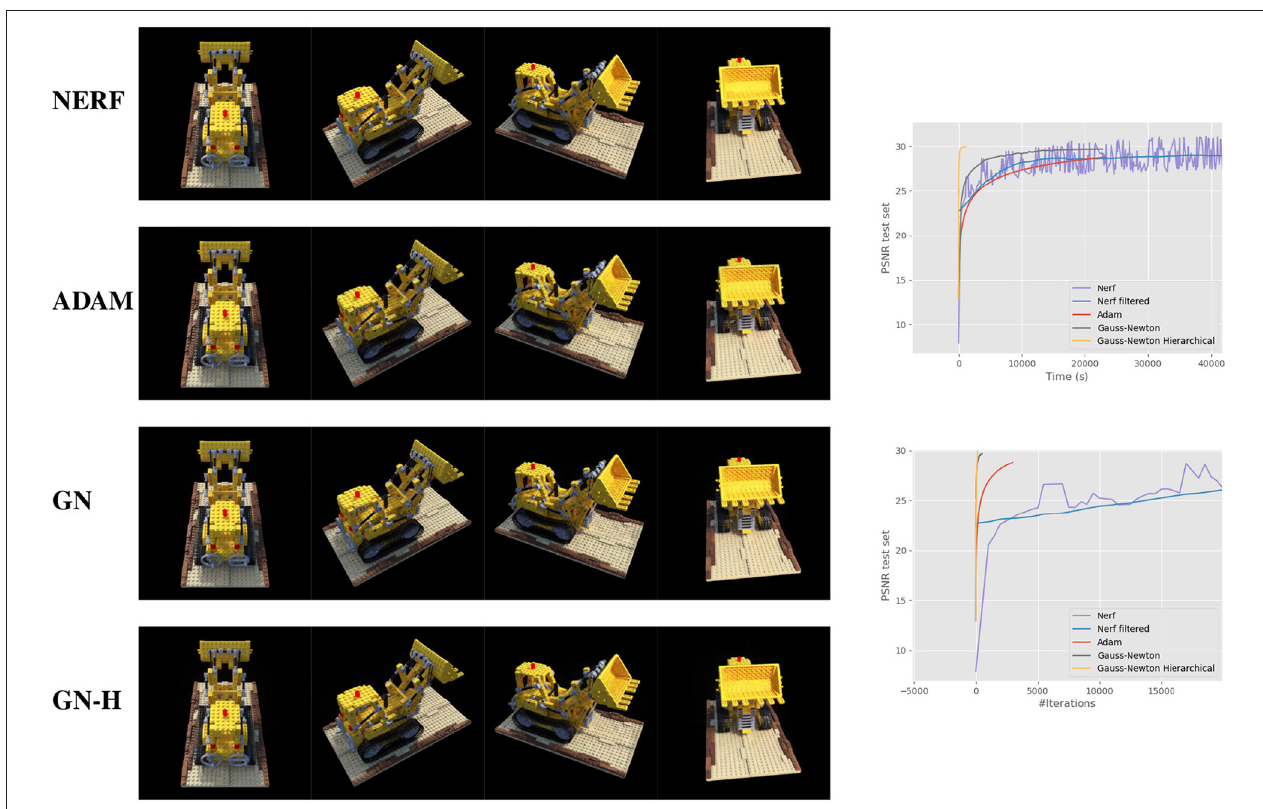
FIGURE 1 | Hold out views for the lego scene comparing NERF (without view-dependence), pure ADAM-optimization, regular Gauss-Newton optimization and a hierarchical Gauss-Newton formulation; from top to bottom. To the top-right the corresponding PSNR-curves are shown vs. time; to the bottom-right PSNR is plotted vs. number of